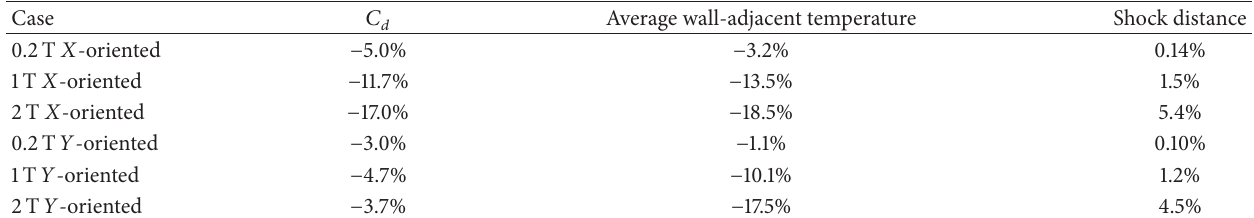
Table 1: Percent changes in 𝐶 𝑑 , average wall-adjacent temperature, and shock-standoff distance for various 𝐵 max . Case 𝐶 𝑑 Average wall-adjacent temperature Shock